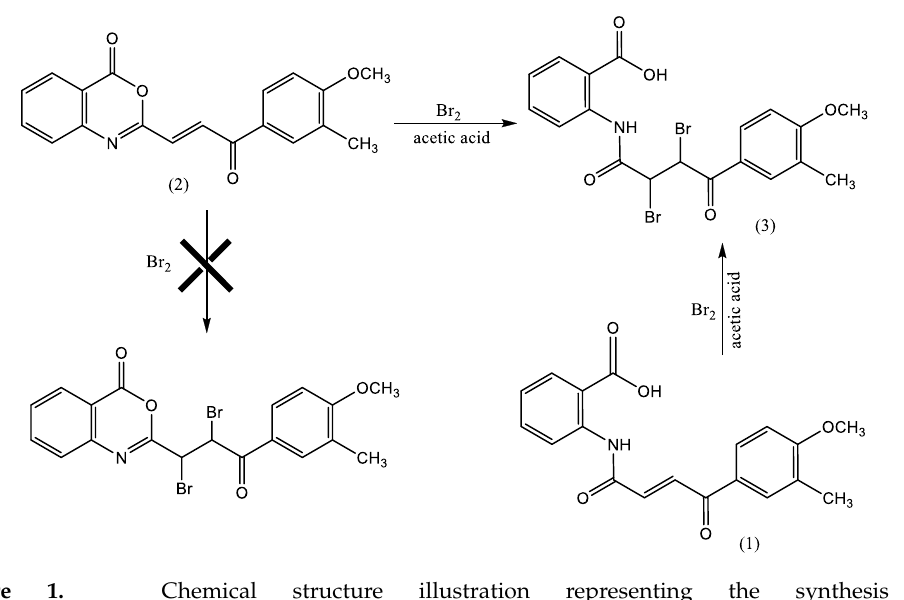
Figure 1. Chemical structure illustration representing the synthesis of N-[2,3-Dibromo-4-(4-methoxy-3-methylphenyl)-4-oxobutanoyl]anthranilic acid ( 3 ) ( OA ).